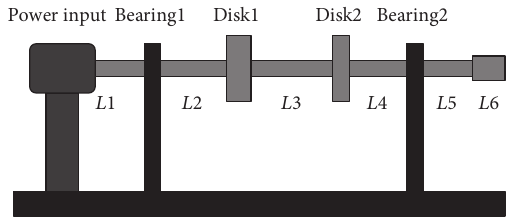
Figure 2: Schematic structure of the two-disk flexible rotor system.